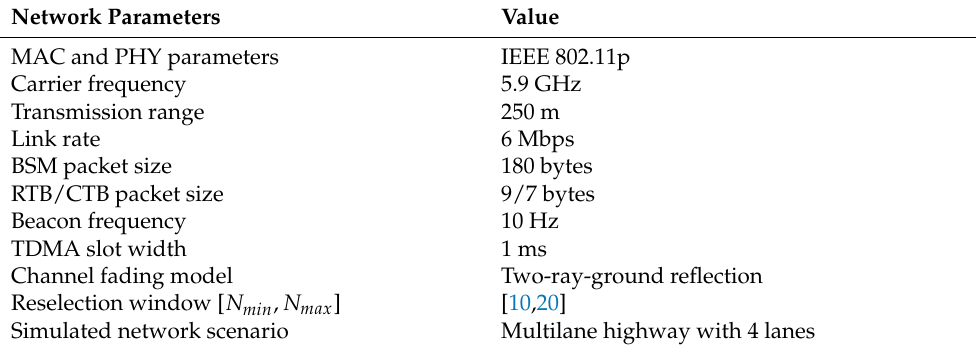
Table 2. Simulation